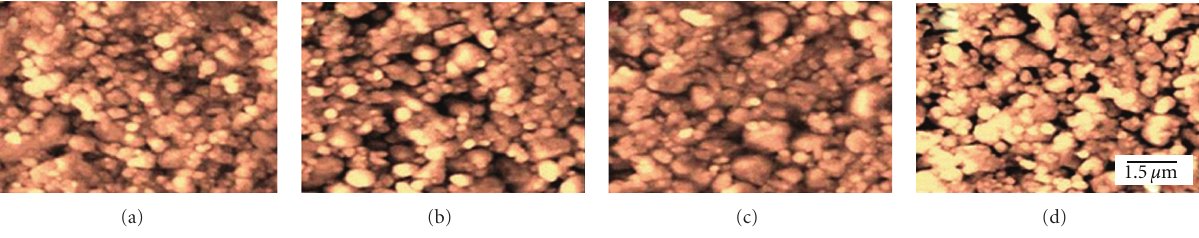
Figure 8: SEM micrographs of BaTiO 3 -CuO + x wt% Ag sensors sintered at 700 ◦ C, (a) x = 0, (b) x = 1, (c) x = 1 . 5, and (d) x =